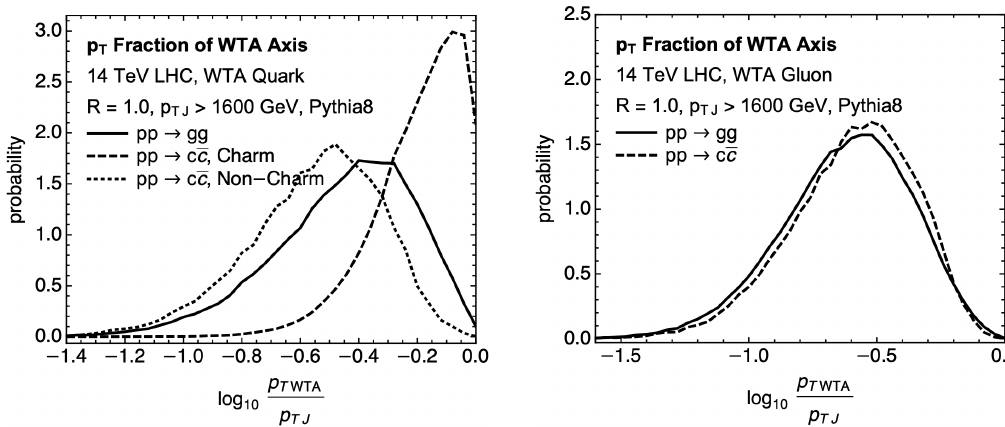
Figure 4 . Distribution of the transverse momentum fraction of the particle that lies along the WTA axis, for WTA quark-flavor (left) and gluon-flavor (right). Different curves correspond to different initiating high-energy